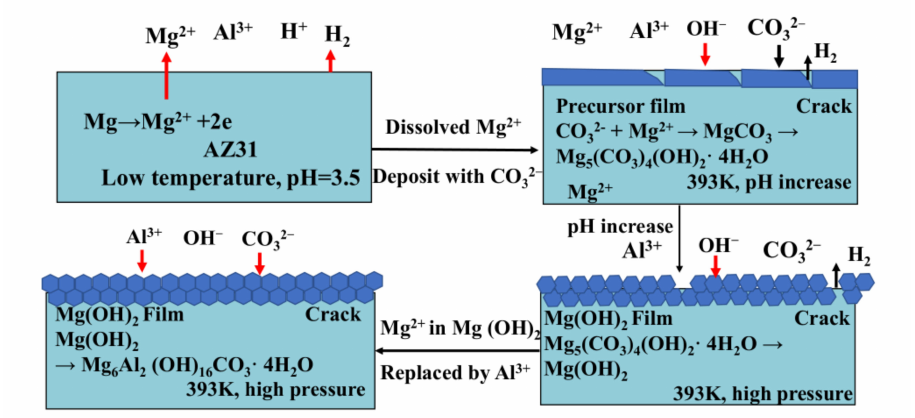
Figure 5. Schematic diagram of Mg–Al LDH film. Adapted with permission from [37]; Copyright 20215